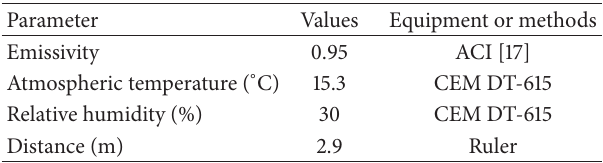
Table 3: Technical specifications of FLIR camera SC660 [16].